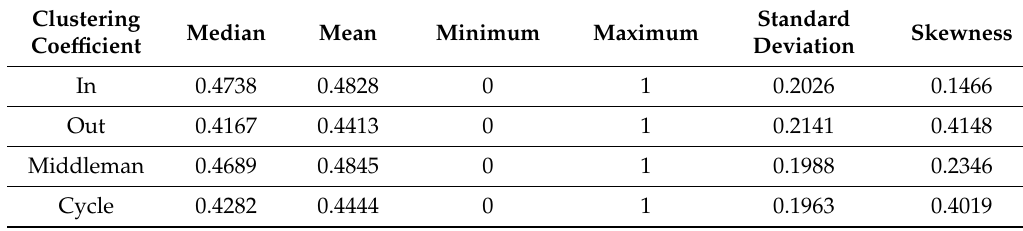
Table 5. Main statistics for clustering coe ffi